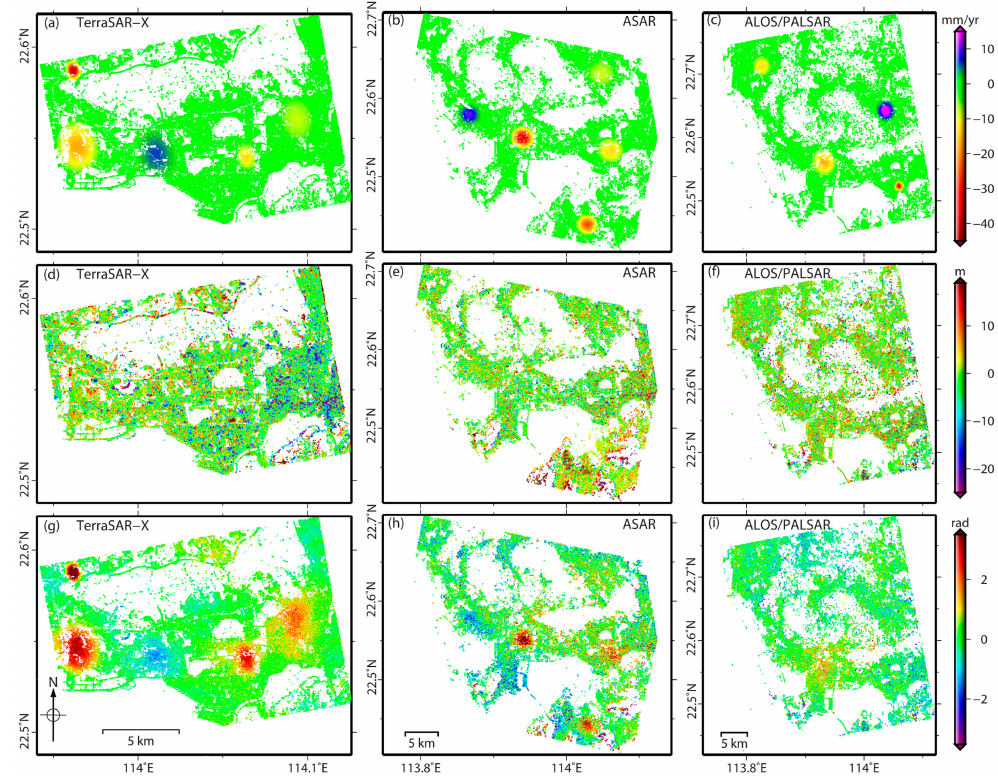
Figure 3. Simulated deformation rate maps and topographic residuals maps for three different platforms: ( a – c ) the simulated deformation rate maps for X, C and L bands, respectively, wherein five simulated deformation funnels are for X and C bands and 4 are for L band; ( d – f ) the topographic residuals, derived from the difference between SRTM-1arc DEM and TanDEM-X DEM, for X, C and L bands, respectively; and ( g – i ) the simulated unwrapped phase of three bands with a time interval of 165, 175 and 184 days,